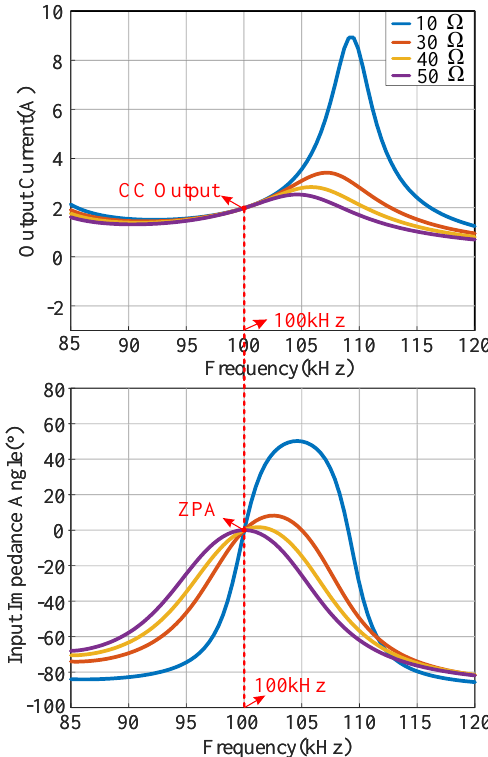
Figure 4. The sweep frequency curves of the output current and input impedance angle of the system under different load